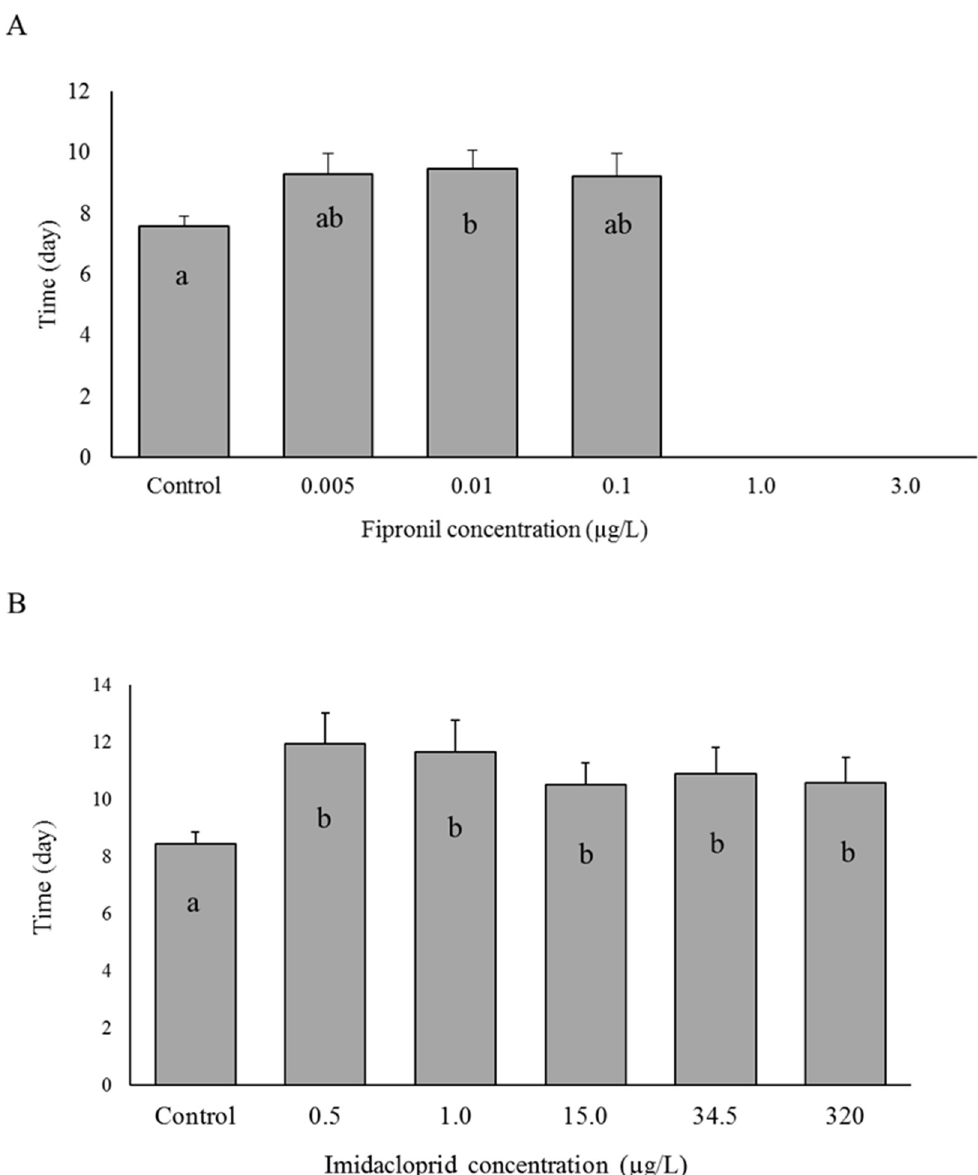
Fig 2. Inter-moult interval of juvenile shrimp under different concentrations of fipronil and imidacloprid. The vertical axis is the time (days) between consecutive moults of the same individual, and the horizontal axis is the six insecticide concentrations ( μ g/L) including the control. Error bars indicate the standard errors (n = 18 in fipronil exp. and n = 15 in imidacloprid exp.). ( A ) Fipronil experiment, ( B ) Imidacloprid